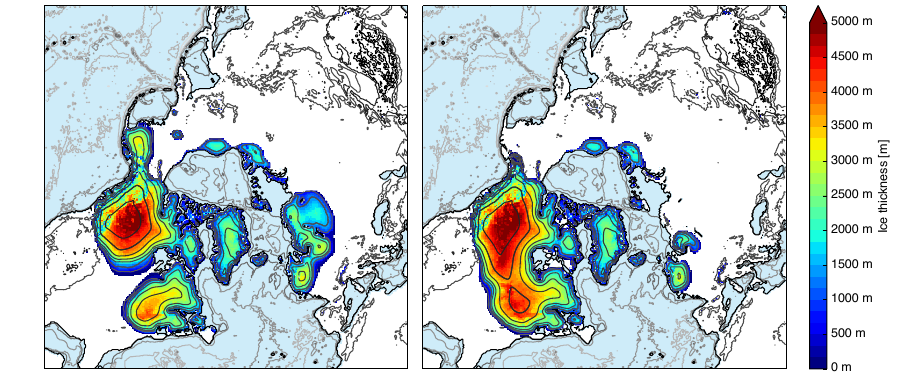
Figure 8. Ensemble composite of all simulations within LGM ice volume range of − 132 and − 95ms . l . e . (see gray horizontal bar in Fig. 7) (Clark and Mix, 2002). Ensemble LGM uc (left, mean − 111.9ms . l . e . ) consists of 50 simulations, and LGM bs climate forcing (right, mean − 114.7ms . l . e . ) has 114 members.